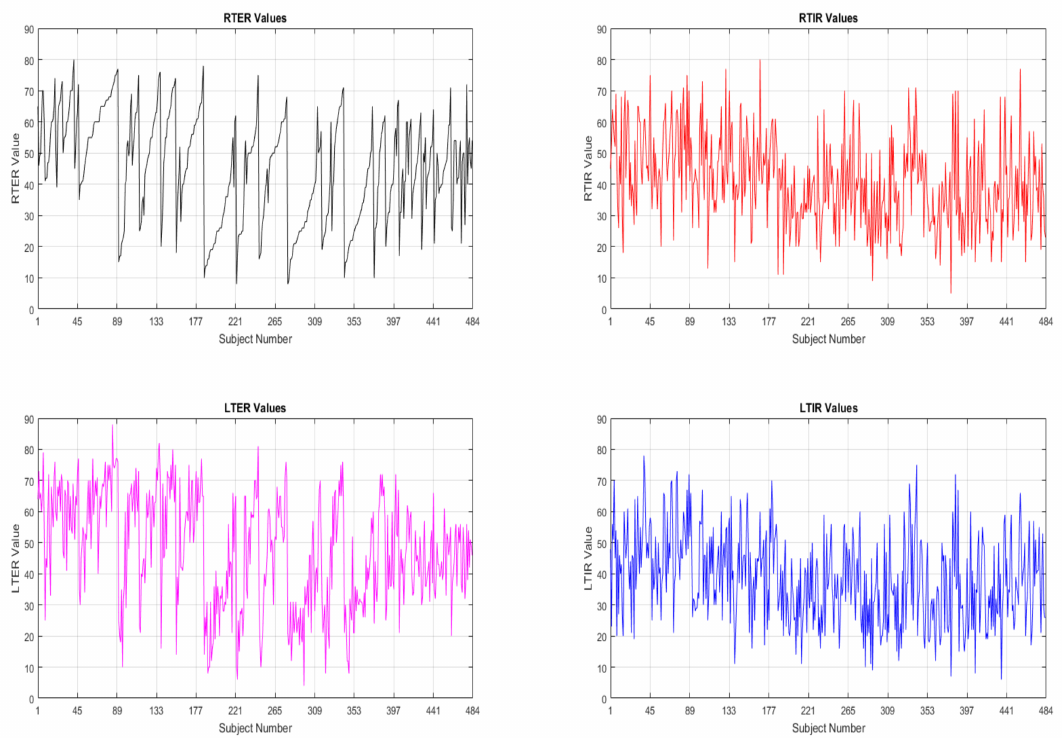
Figure 2. Tibial rotation values of every